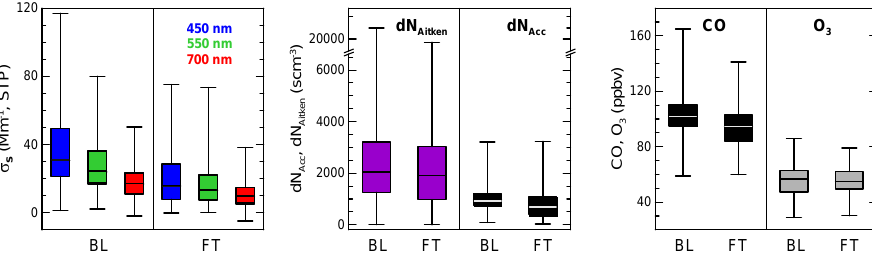
Figure 5. Box and whisker plot of the aerosol scattering coefficient ( σ s ) at 450, 550, and 700nm, particle concentration in the Aitken (d N Aitken ) and accumulation (d N Acc ) modes, and CO and O 3 measured within pollution plumes in the boundary layer (BL) and in the free troposphere